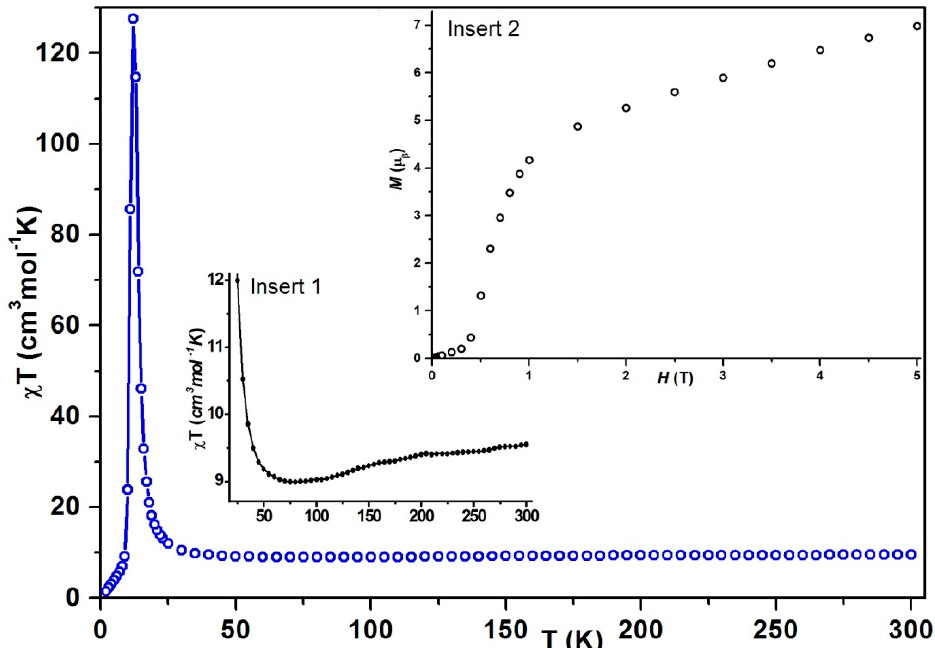
Figure 7. Magnetic data for a polycrystalline sample of 11 : the temperature dependence of χ T (blue, solid line) registered at H = 5 kOe. (insert 1: zoom of the χ T plot) [44]. Insert 2: the field dependence of magnetization at 2 K [44].